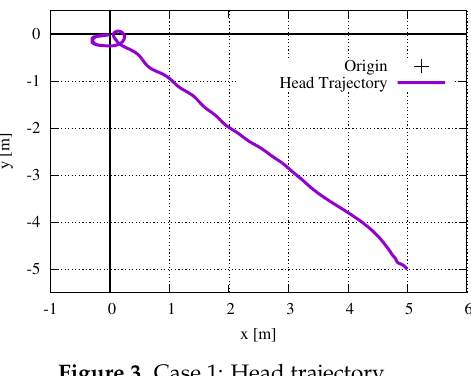
Figure 3. Case 1: Head trajectory.